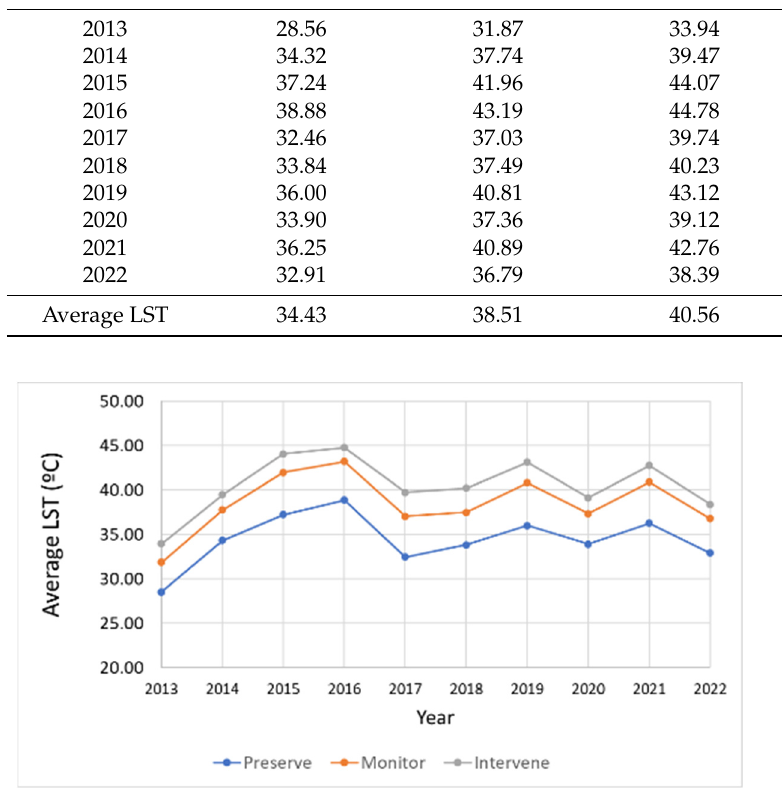
Figure 17. Average LST per year per class of action. Table 19. Average LST (°C) per year per IUHI class of action.